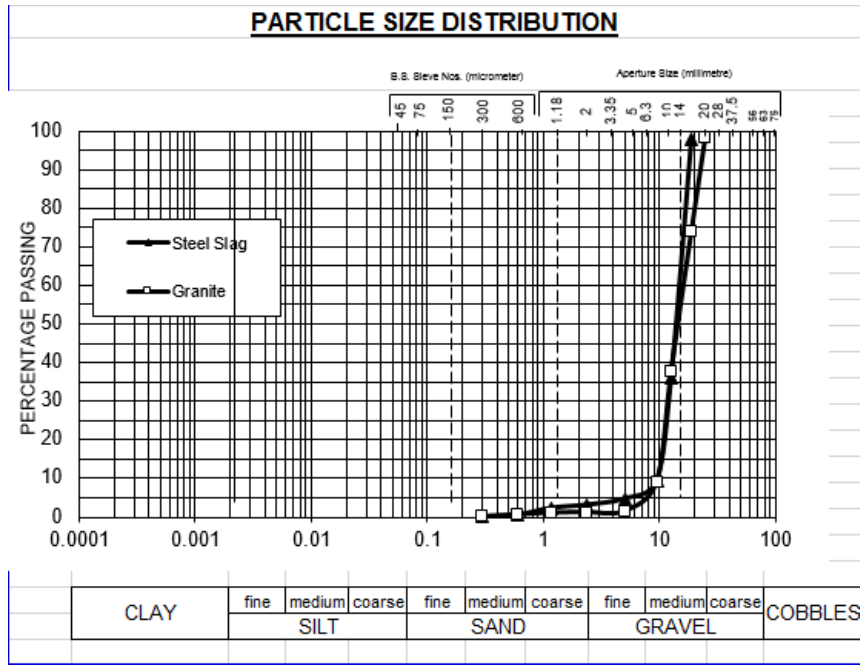
Figure 2. Particle size distribution curve for granite and steel slag